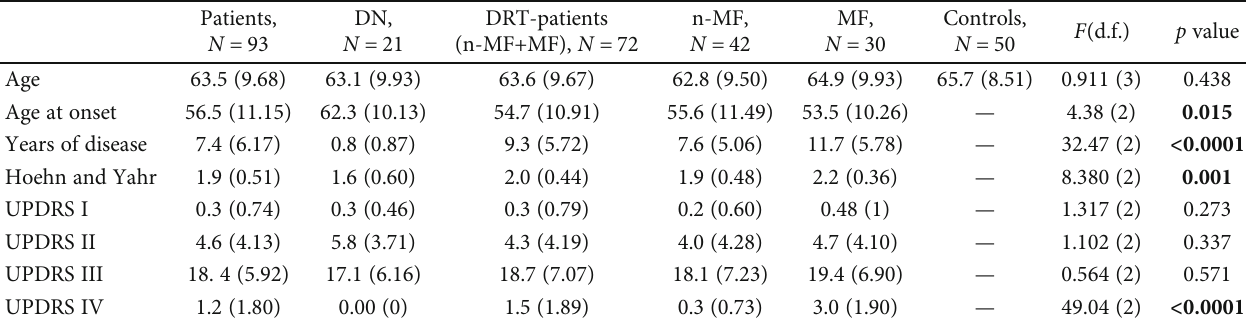
Table 1: Demographic and clinical data of patients with Parkinson ’ s disease and